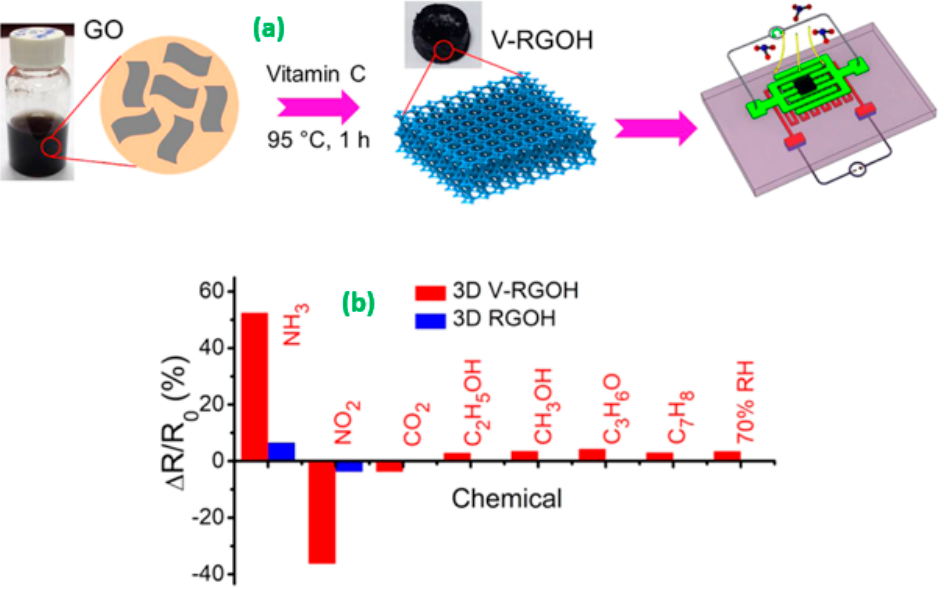
Figure 9. ( a ) Schematic depicting the green synthesis of 3D V-RGOH from GO with the aid of VC via self-assembly, for gas detection. Insets: photos of the GO aqueous dispersion (left) and 3D V-RGOH (middle). The chemiresistor and microheater were generated on the front and back sides of the Si / SiO 2 substrate, respectively. ( b ) Responses of 3D V-RGOH and RGOH to 100 ppm NH 3 ; 10 ppm NO 2 ; 500 ppm CO 2 ; saturated ethanol, methanol, acetone, and toluene vapors; and 70% RH. Reproduced from Wu, J.; Wei, Y.; Ding, H.; Wu, Z.; Yang, X.; Li, Z.; Huang, W.; Xie, X.; Tao, K. and Wang, X., 2020. Green Synthesis of 3D Chemically Functionalized Graphene Hydrogel for High-Performance NH 3 and NO 2 Detection at Room Temperature, ACS Appl. Mater. Interfaces, 12, pp. 20623–20632 [121].